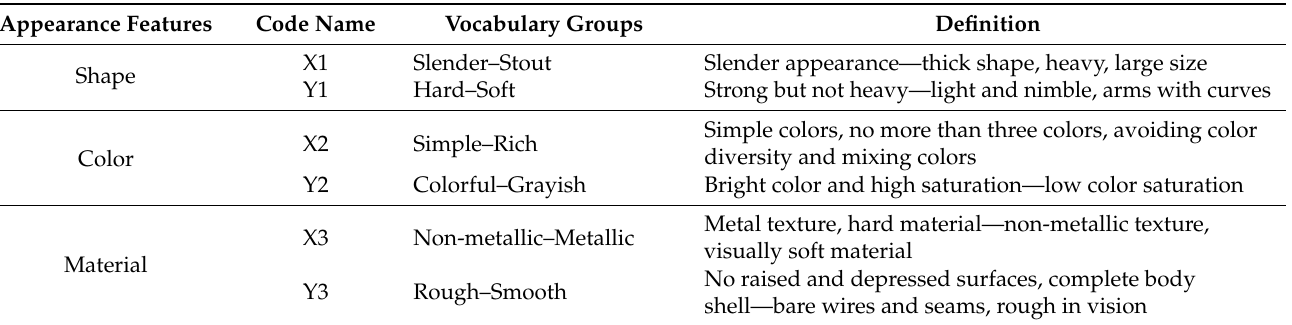
Table 1. Six groups of perceptual vocabulary.